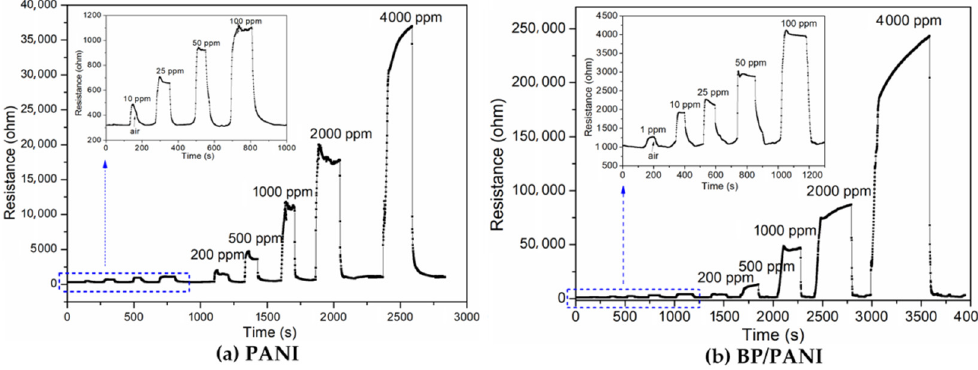
Figure 4. Response transients of ( a ) PANI and ( b ) BP/PANI thin films exposed to different concentrations of NH 3 at room temperature.